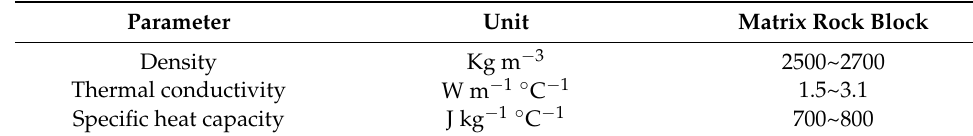
Table 1. Rock mass parameters.